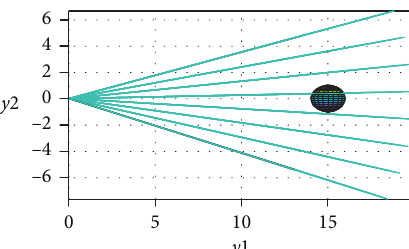
Figure 5: Front projection of the 3D lidar’s view for one obstacle in 5 m.